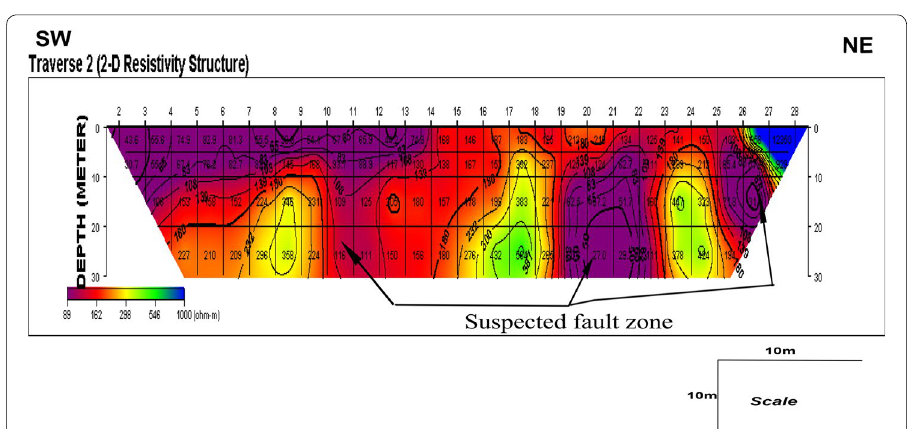
Fig. 11 2-D resistivity structure along traverse 2